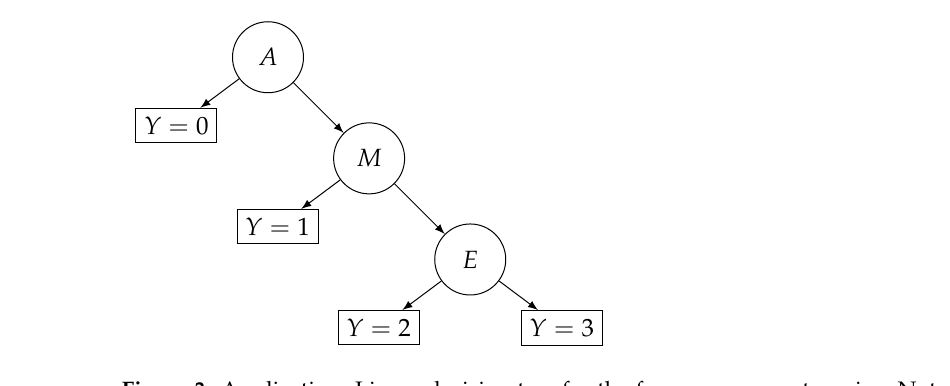
distribution; (b) : Histogram of left spreads ( c i ) distribution; (d) : Histogram of intensification parameters ( ω c i − i